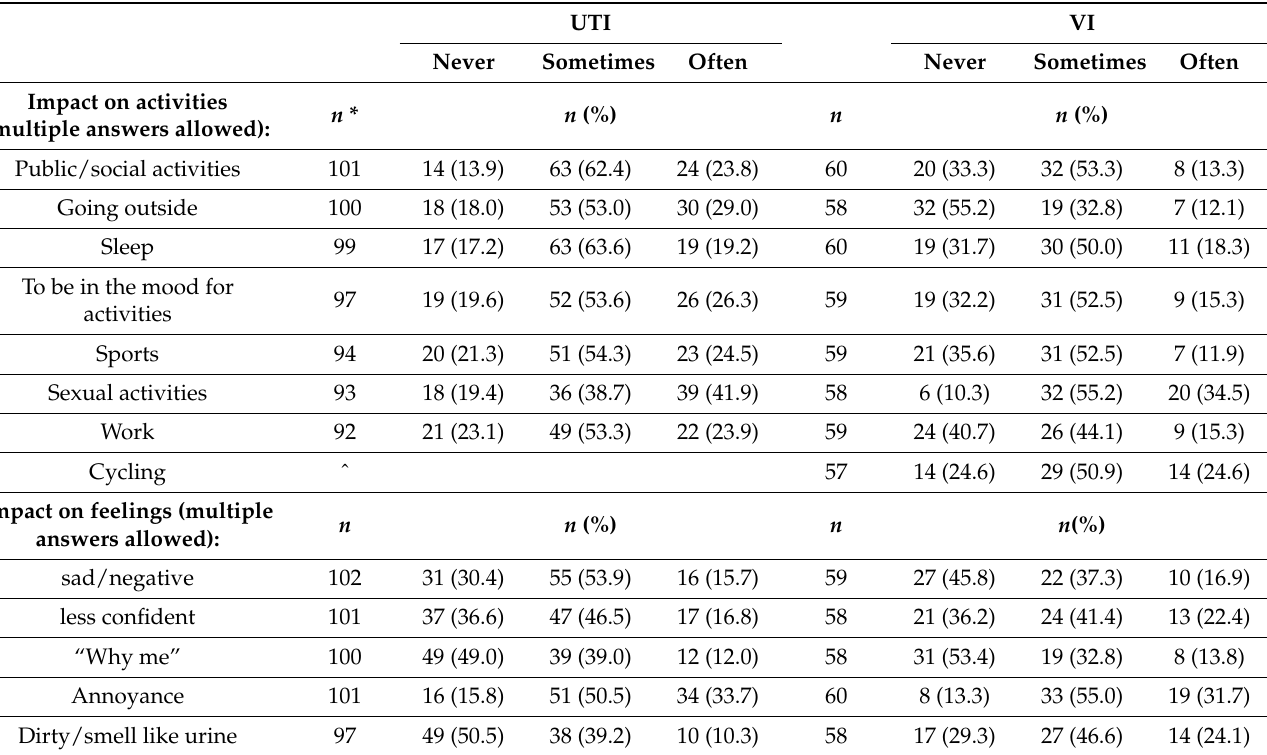
Table 4. UTI/VI interference with daily activities in women with a history of UTI ( n = 162) and women with a history of UTI and VI ( n = 80). UTI VI Never Sometimes Never